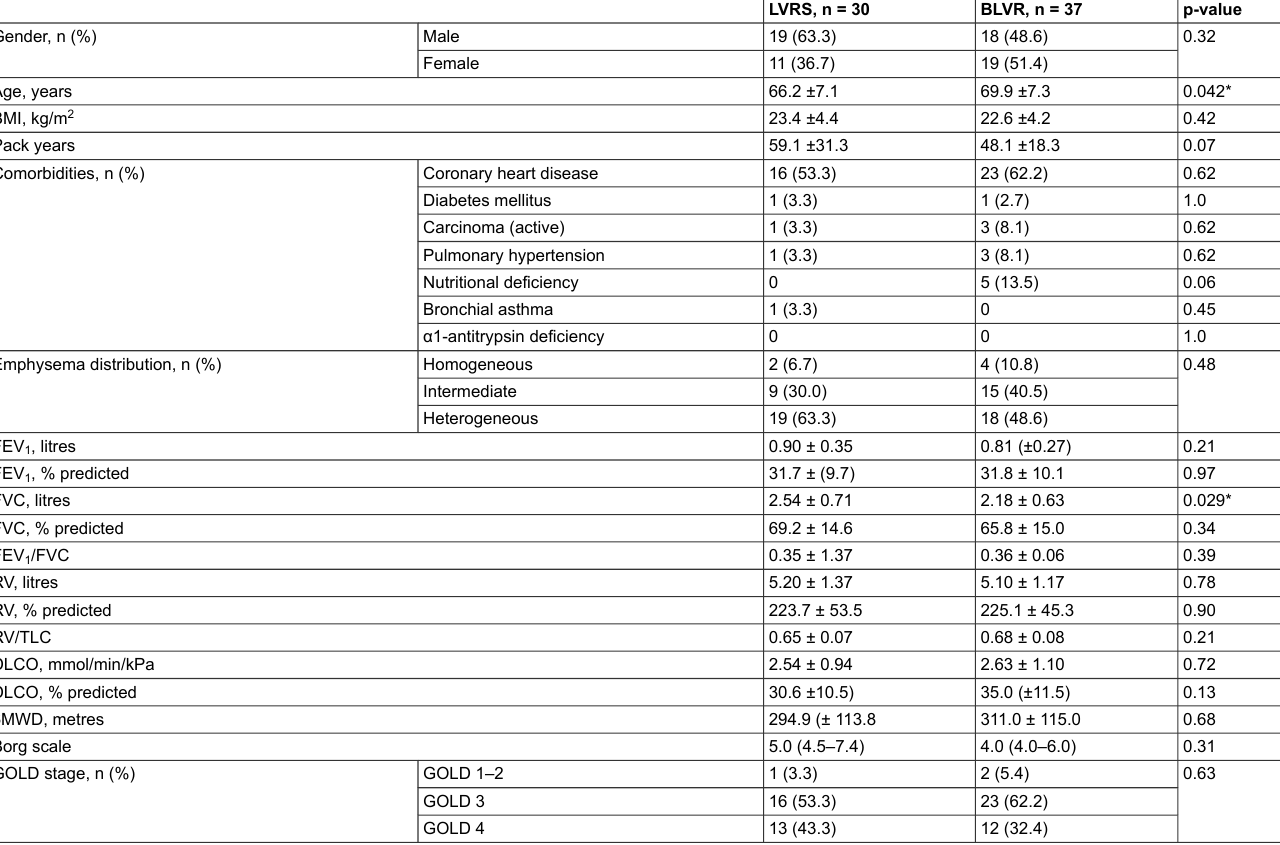
Except for the Borg scale (median value, interquartile range), all continuous data are given as mean values ± standard deviation. BMI: body mass index; BLVR: bronchoscopic lung volume reduction (with endobronchial valves); FEV 1 :, first-second capacity; FVC: forced vital capacity; RV: residual volume; TLC: total lung capacity; DLCO: diffusing capacity of the lungs for carbon monoxide; GOLD: Global Initiative of Obstructive Lung Disease; LVRS: lung volume reduction surgery; 6MWD: 6-minute walking distance. *p